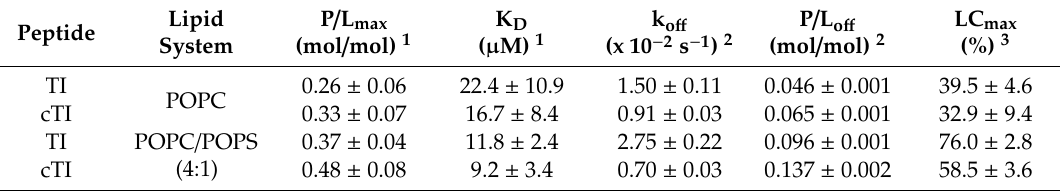
To examine the ability of cTI to bind model membranes that mimic bacterial zwitterionic phosphatidylethanolamine (PE)-phospholipids, negatively-charged